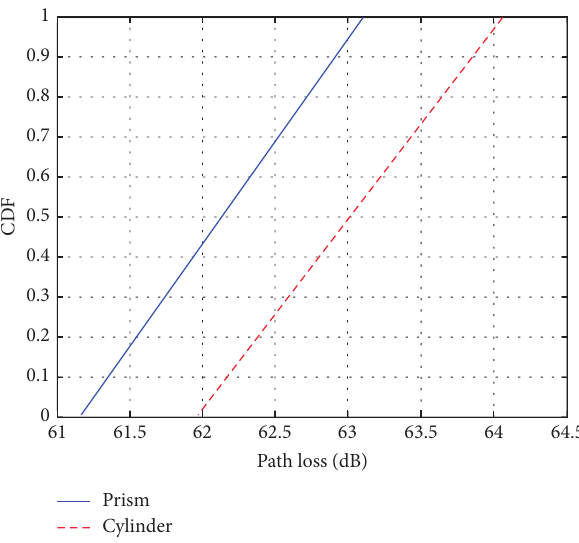
Figure 16: CDFs of the PL with the Rx on the left thigh. Table 15: Simulation and measurement results around the leg.